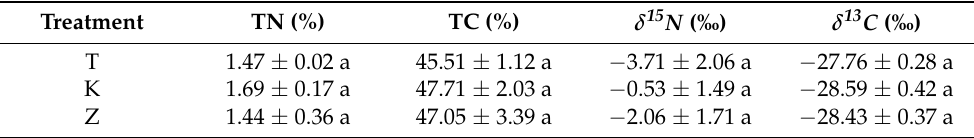
Table 1. Results of leaves analysis (EA-IRMS) from each experimental plant treated with kaolin (K), CHA-zeolitite (Z) and the control (T). TN and TC are the total nitrogen and carbon content measured by EA analysis, δ 15N and δ 13C are the isotopic signatures expressed as delta notation by IRMS. Values are expressed as the mean of three replicates ± standard deviation. The same letters in the same column express no significant differences ( p > 0.05) as results of ANOVA and Tukey’s (HSD)